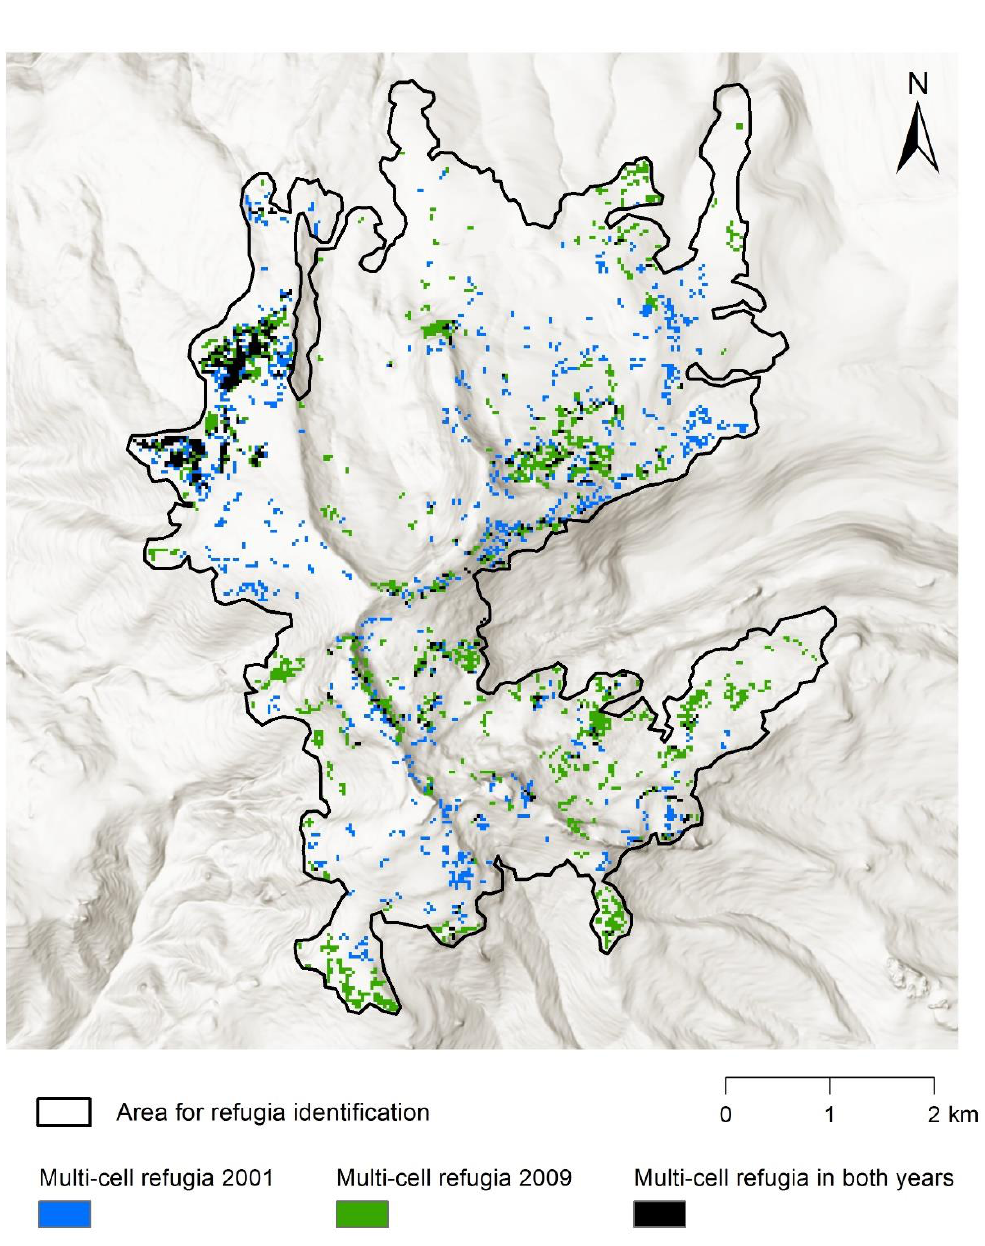
Figure A3. Spatial overlap between multi-cell refugia identified in 2001 and 2009. Approximately 30% of multi-cell refugia grid cells in 2001 were also identified as multi-cell refugia in 2009.